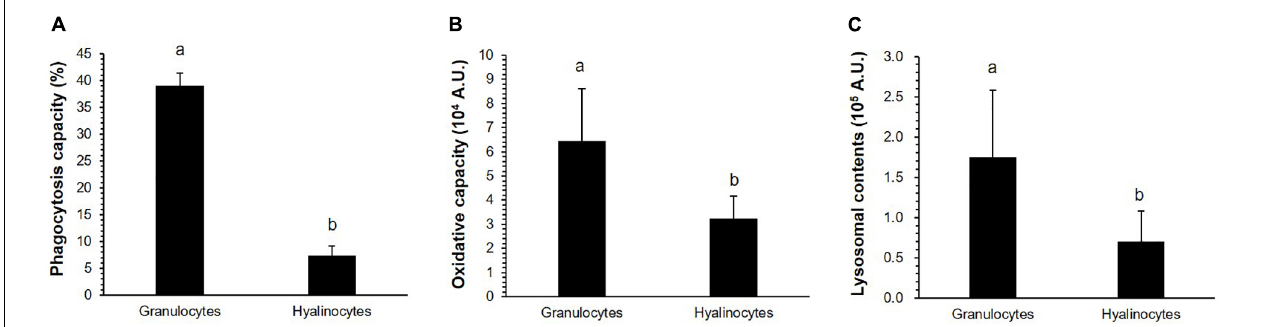
FIGURE 4 | (A) Phagocytosis capacity, (B) oxidative capacity, and (C) lysosomal contents in granulocytes and hyalinocytes of Mytilisepta virgata determined by flow cytometry. Values are presented as the mean ± standard error. Different letters in the columns represent significant ( t -test, P < 0.05) differences between the granulocytes and hyalinocytes.